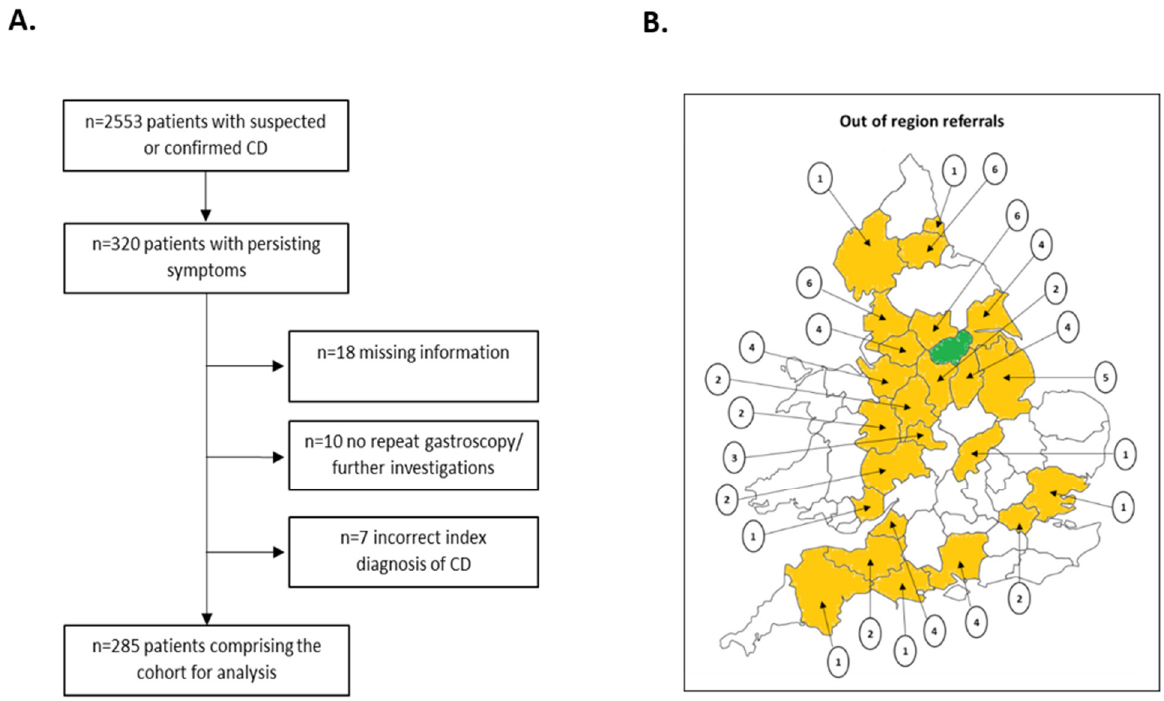
Figure 1. ( A ) Flow chart detailing the study patient selection. ( B ) Map of England illustrating the frequency and location of the 69 out-of-region referrals. The counties patients were referred from are highlighted in orange; the encircled numbers represent the number of patients referred from each country; South Yorkshire/Sheffield is highlighted in green. CD = coeliac disease. Table 1. The causes of NRCD in patients with established CD.